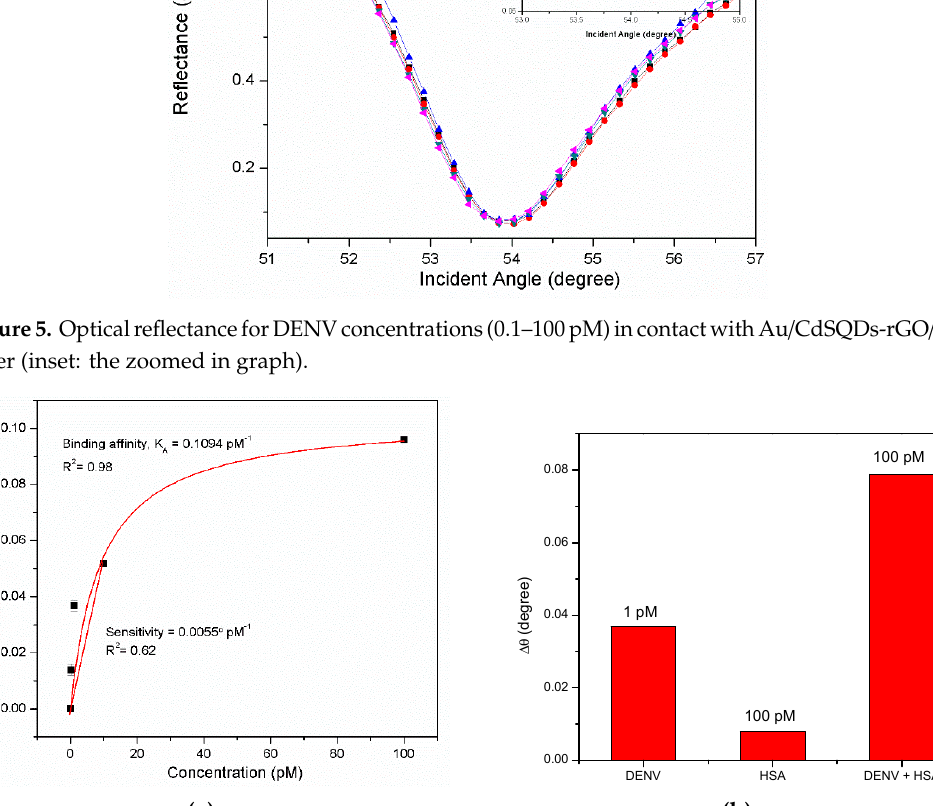
Figure 6. Relationship between the SPR angle shift ( ∆ θ ) and DENV concentration. ( a ) Langmuir and linear fitting; ( b ) Selectivity